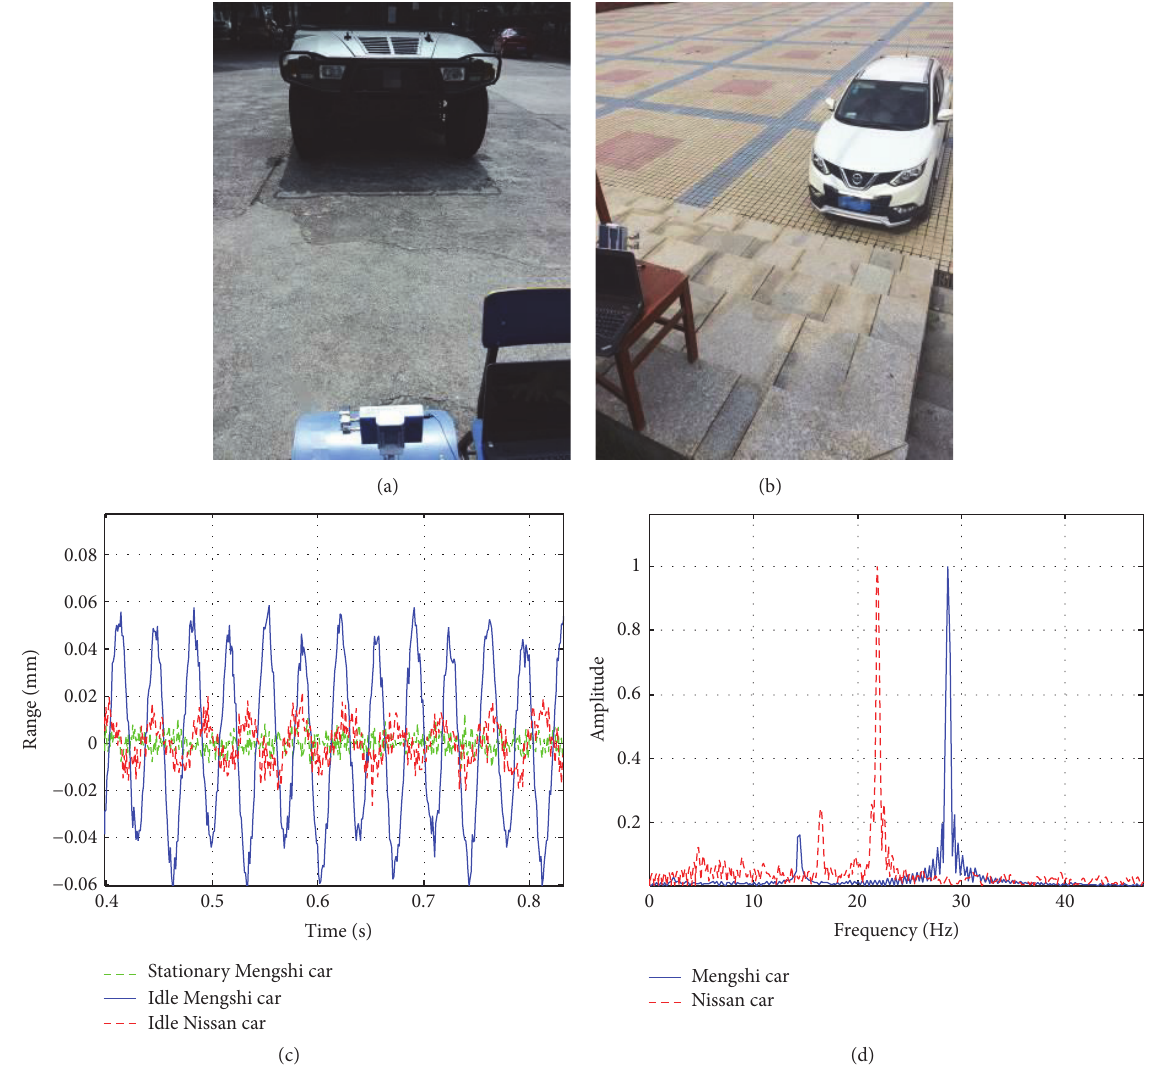
Figure 3: Vibration measurement results of two idle cars: (a) Mengshi car; (b) Nissan car; (c) vibration amplitude versus time; (d) vibration